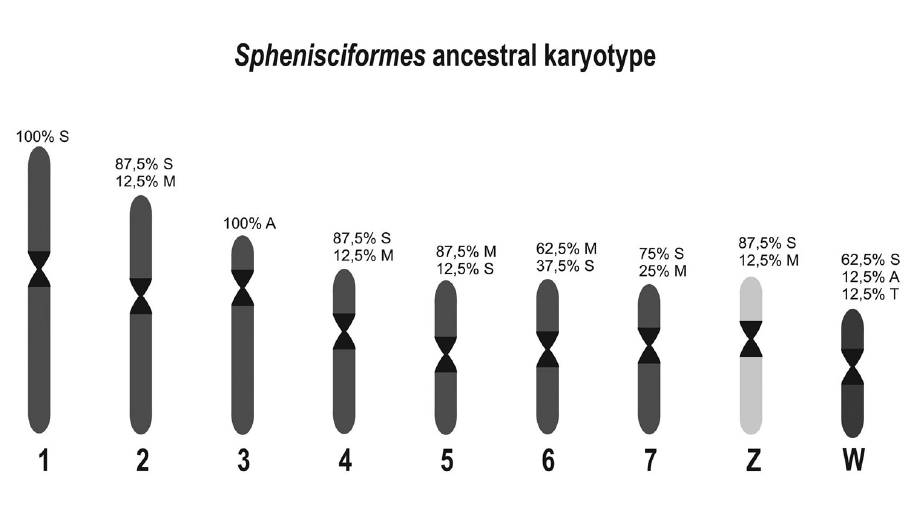
Figure 3. Hypothetical Sphenisciformes ancestral karyotype representing the conserved morphology of the macrochromosomes and ZW chromosomes. The frequencies of the morphologies (Metacentric= M; Submetacentric= S; Acrocentric= A; Telocentric= T) in the current species are represented above each